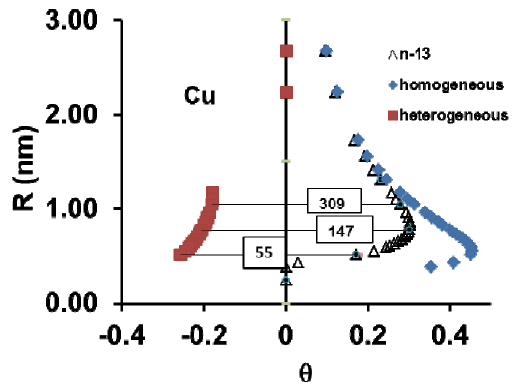
Figure 14. Supercooling temperatures of liquid copper controlled by unmelted superclusters having melting temperatures depending on overheating rate applied during 600 s.